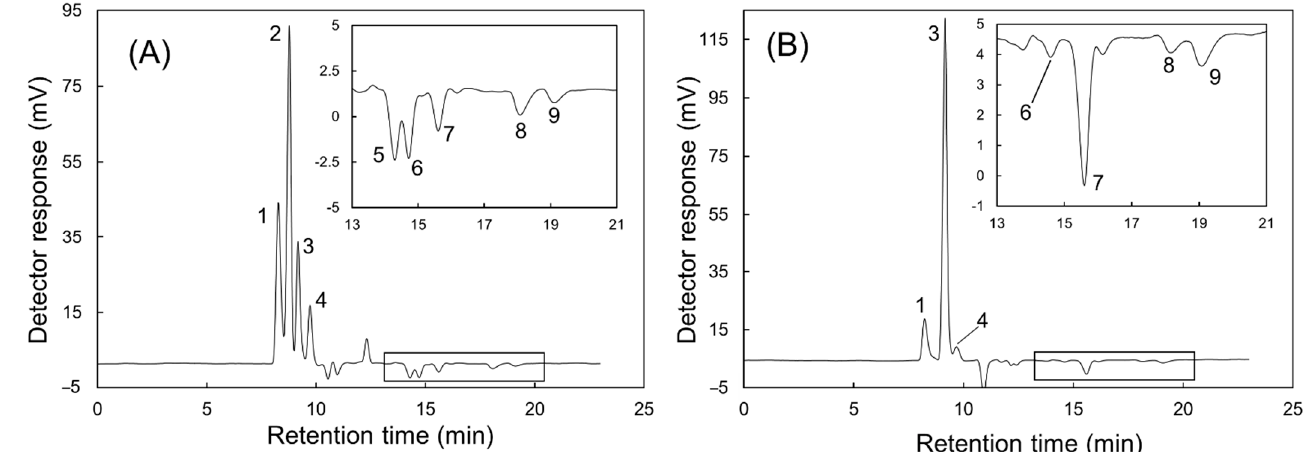
Figure 2. Optimal chromatograms for the separation of ( A ) standard sample, and ( B ) 5-fold diluted fertilizer solution sample collected on day 9. Peaks: (1) SO 42 − , (2) Cl − , (3) NO 3 − , (4) H 2 PO 4 − , (5) Na + , (6) K + , (7) NH 4+ , (8) Mg 2+ , and (9) Ca 2+ . Conditions: Column: Two Tosoh TSKgel Super-IC-A/C (6.00 mm I.D. ×150 mm) and a Shodex SH-1011 (8.00 mm I.D. ×300 mm) connected in tandem; column temperature: 55 °C; injection volume: 20 µL; eluent concentration: 5 mM tartaric acid and 3 mM 18-crown-6; eluent flow rate: 1.0 mL/min. Injected samples: ( A ) mixture of 1.0 mM MgSO 4 , NaCl, NH 4 NO 3 , KH 2 PO 4 , and CaCl 2 , and ( B ) 5-fold diluted fertilizer solution sample collected on day 9.